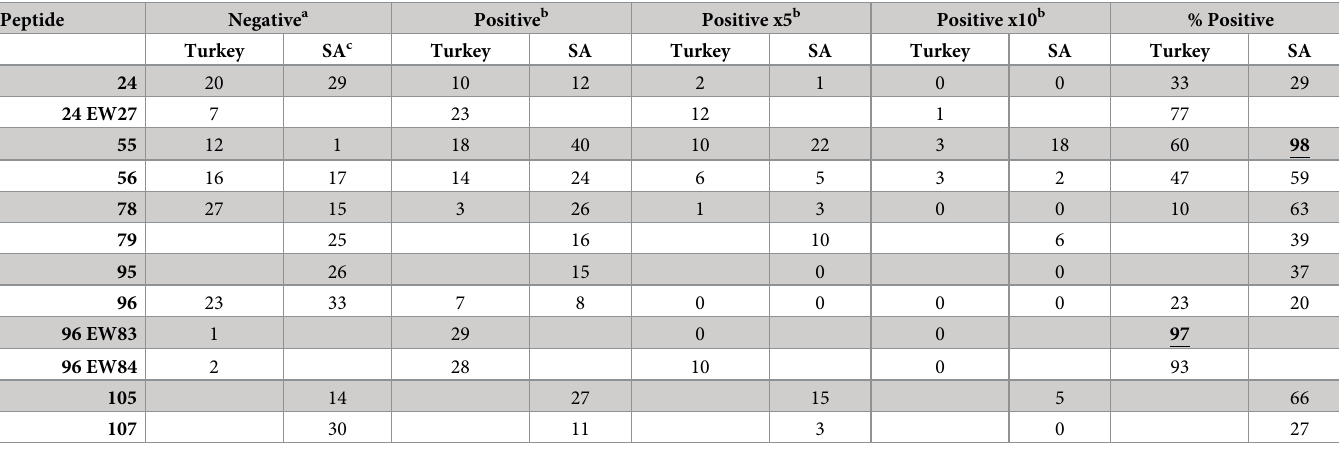
Table 2. Reactivity of Turkish (n = 30) and South African sera (n = 41) against nine selected peptides.